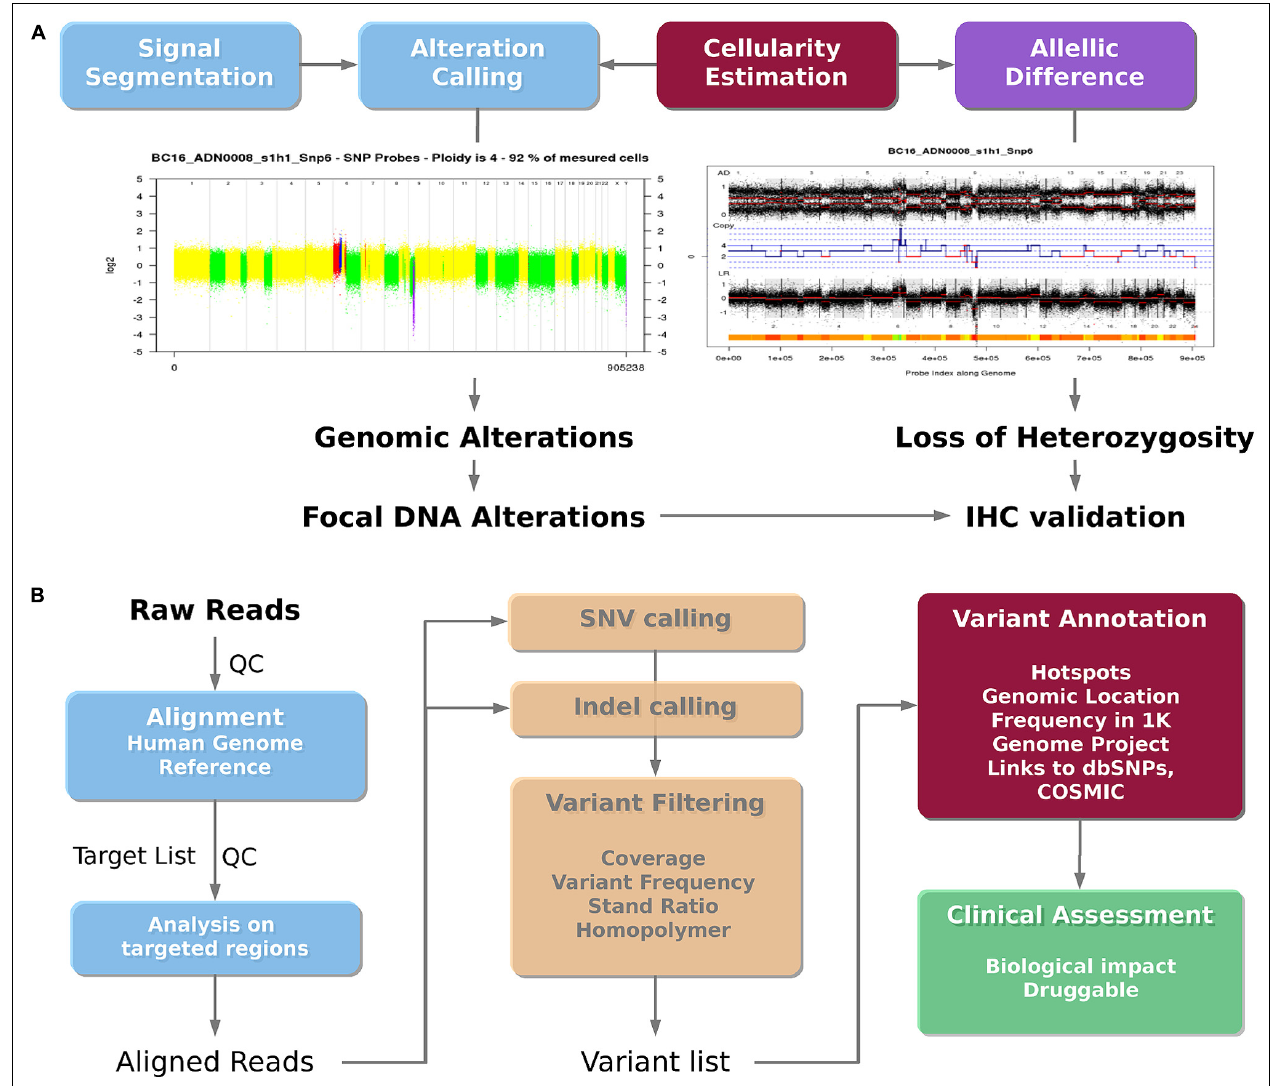
(B) Mutation analysis pipeline.The sequenced reads are aligned on the human reference genome, and centered on the targeted genomic regions. Single nucleotide variations (SNVs) and insertion/deletion (indels) are then called.The filtered variations can then be annotated using additional databases in order to lead to a final list of potential druggable